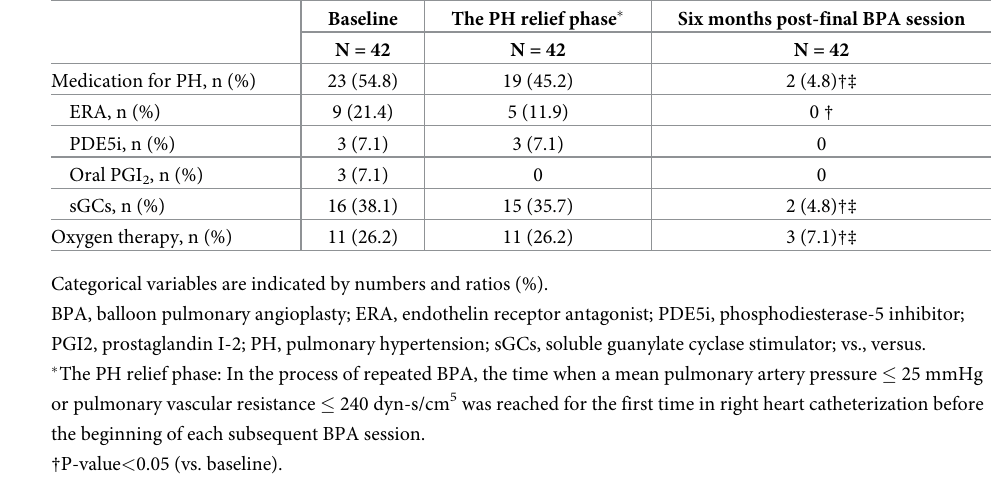
PLOS ONE | https://doi.org/10.1371/journal.pone.0254770 July 16,